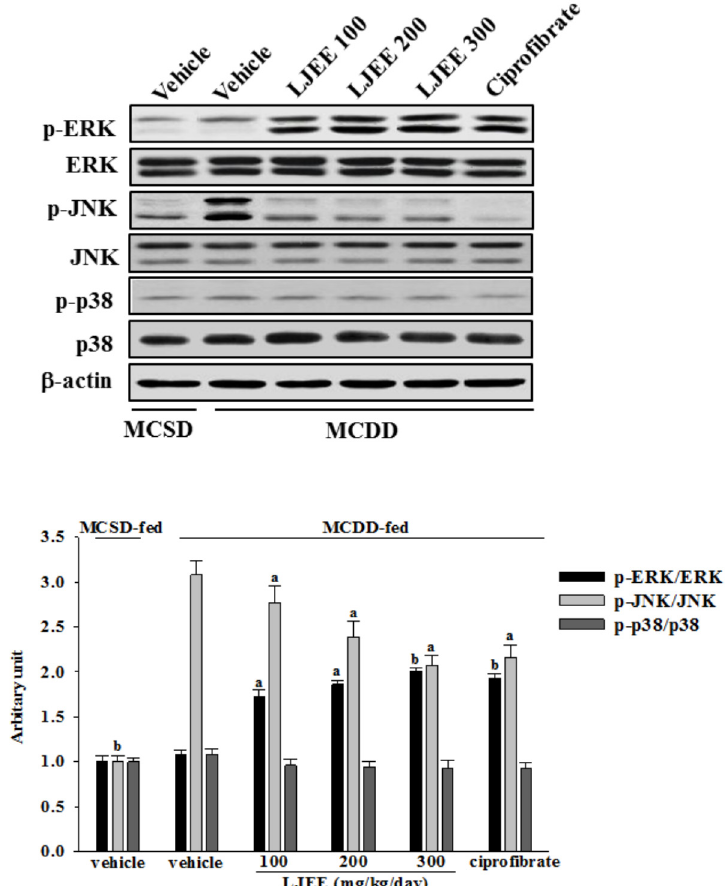
Figure 2. Effects of treatments on mitogen-activated protein kinase (MAPK) signaling pathways in livers of mice. A representative western blot pattern of hepatic MAPK activation from MCSD- and MCDD-fed mice after four weeks of LJEE or ciprofibrate treatment. MCDD-fed mice were dosed by oral gavage once daily for four weeks with LJEE at 100 (LJEE 100), 200 (LJEE 200) or 300 mg/kg/day (LJEE 300). Another group of MCDD-fed mice was orally administered 10 mg/kg/day of ciprofibrate (ciprofibrate). MCSD- or MCDD-fed mice receiving vehicle treatment were given the same volume of vehicle (distilled water) used to prepare the tested medication solutions. Ratios of p-ERK/ERK, p-JNK/JNK, or p-p38/p38 expressed as the mean with SD ( n = 8 per group) in each column have been shown in the lower panel. a p < 0.05 and b p < 0.01 compared to the values of vehicle-treated MCDD-fed mice in each group, respectively.